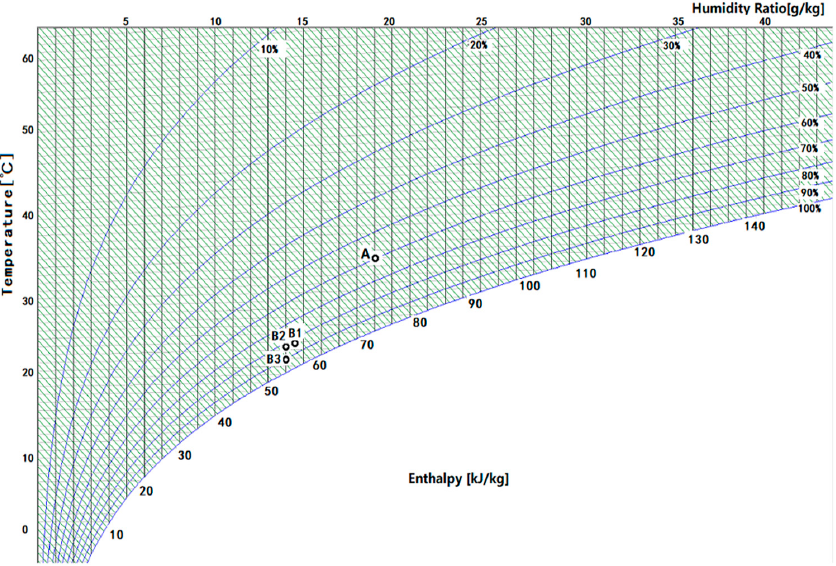
Figure 3. Psychrometric chart.